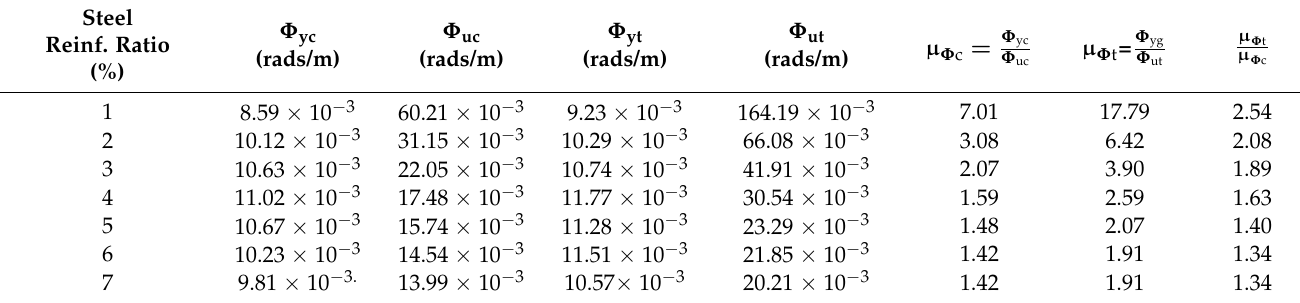
Table 6. Parametric study results for various steel reinforcement ratios and associated curvature ductility indices for control and tube beam cases.